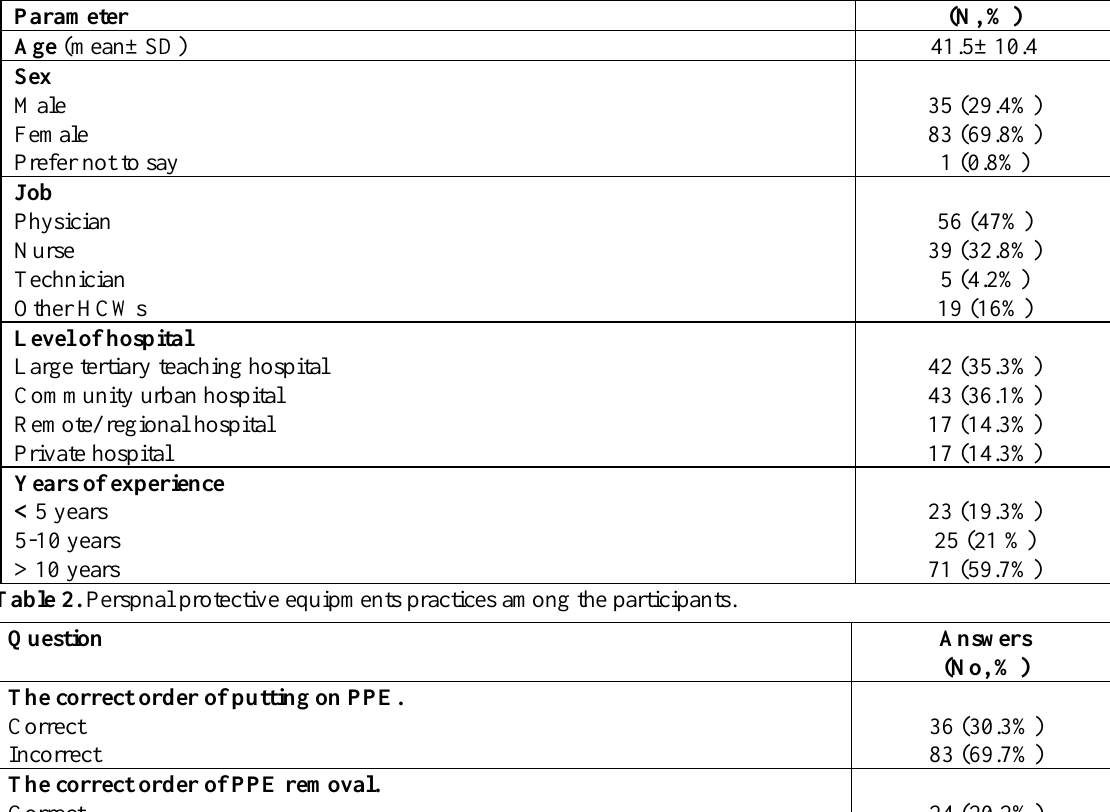
Table 2. Perspnal protective equipments practices among the